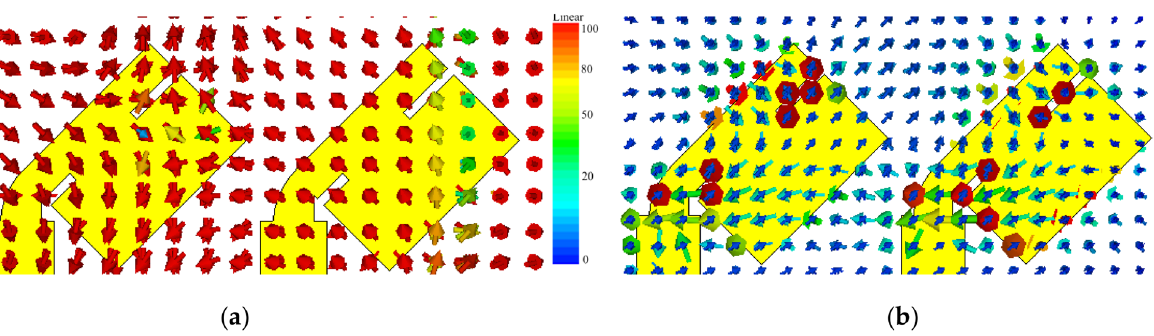
Figure 3. ( a ) E-field distribution and ( b ) H-field distribution of the reported MIMO antenna design at 29